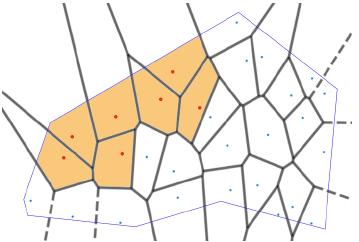
Figure 6. By building the Voronoi diagram, the translation of points marked as ‘deviations’ (red) into a 2D shape becomes possible. As some Voronoi cells might go beyond the roof surface or even be infinite, cropping with the roof surface geometry (in blue) is necessary